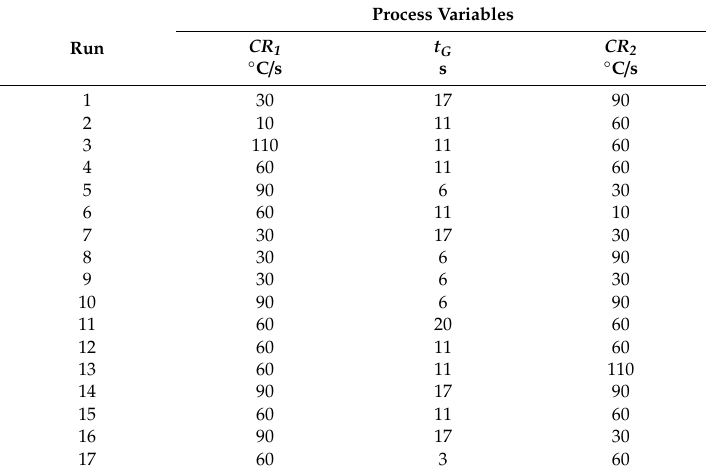
Table 3. Design matrix with independent process